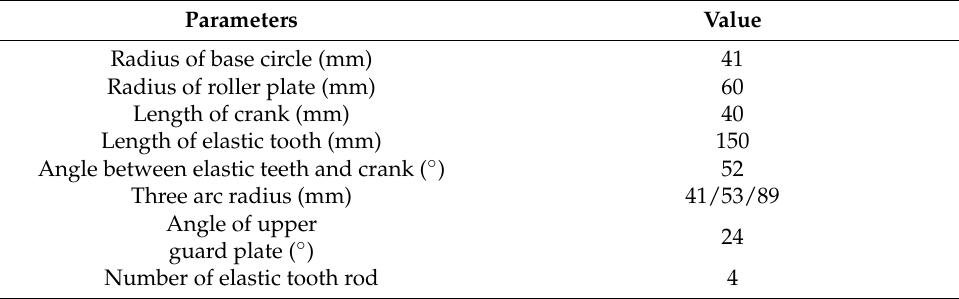
Table 1. Structural parameters of the picking mechanism .